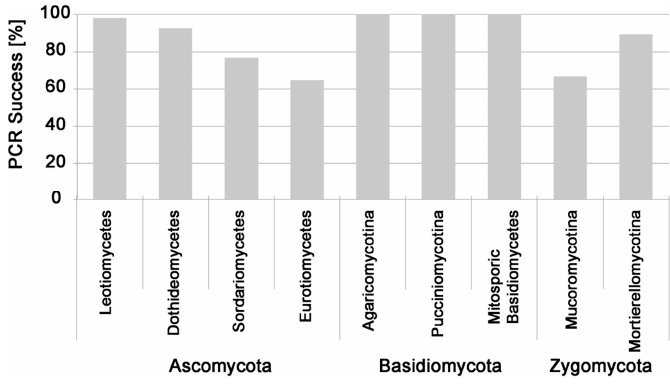
Figure 1. Number of fungal MOTUs tested and successfully amplified with the colony PCR technique, sorted by taxonomic affiliation.